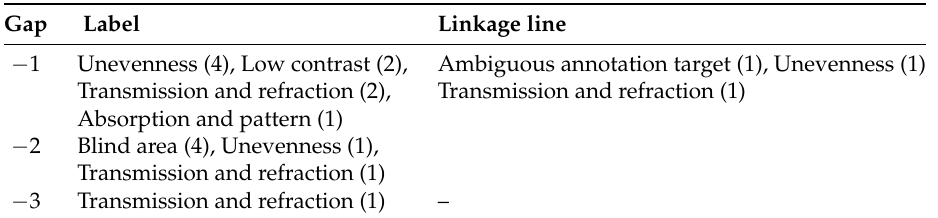
Table 14. The reasons provided by the participants when the system over-estimated. The numbers in the brackets indicate the number of